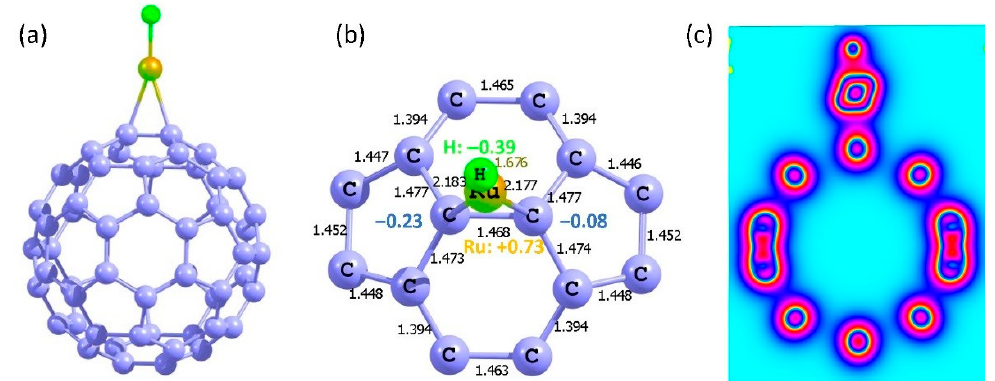
Figure 12. ( a ) Relaxed structure of Ru-supported C 60 , ( b ) bond distances and Bader charges on the Ru and its adjacent C atoms and ( c ) charge density plot showing the interaction of Ru with the surface.